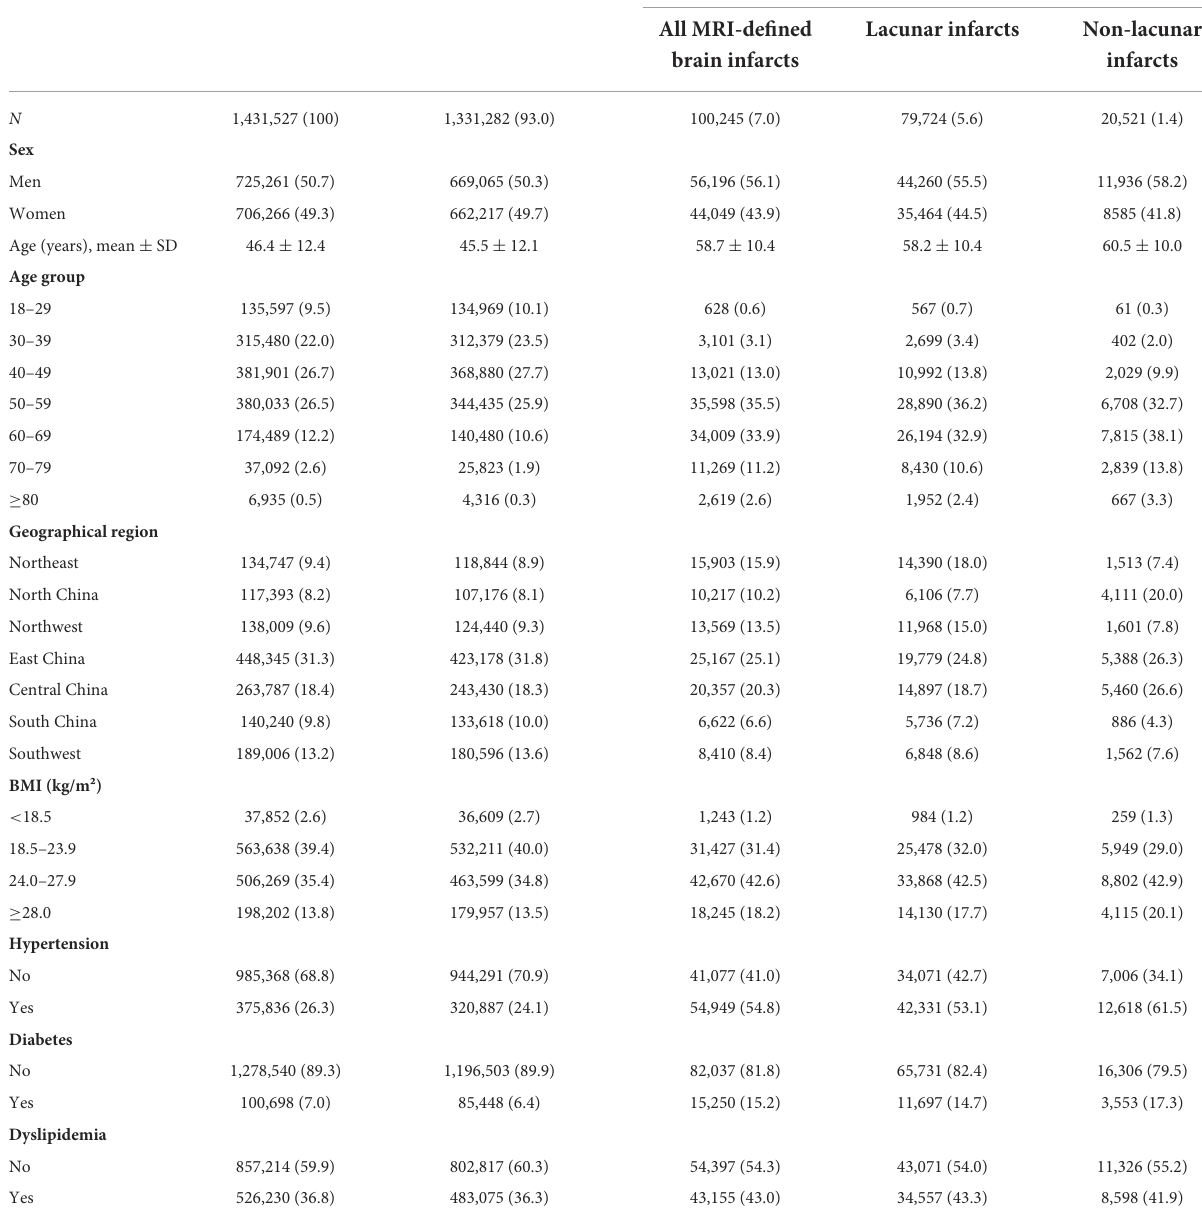
TABLE 1 Characteristics of study participants by MRI-defined brain infarct status a